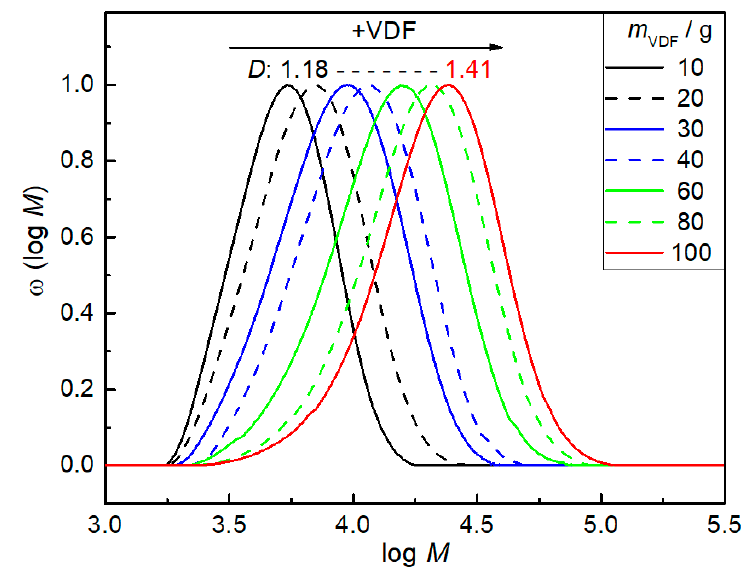
Figure 1. Molar mass distributions of PVDF sampled at the indicated masses of VDF introduced into the reactor. The dispersity increases from 1.18 to 1.41 for polymerizations at 75 °C and 15 bar with 7.5 mmol C 4 F 8 I 2 (sample 7).